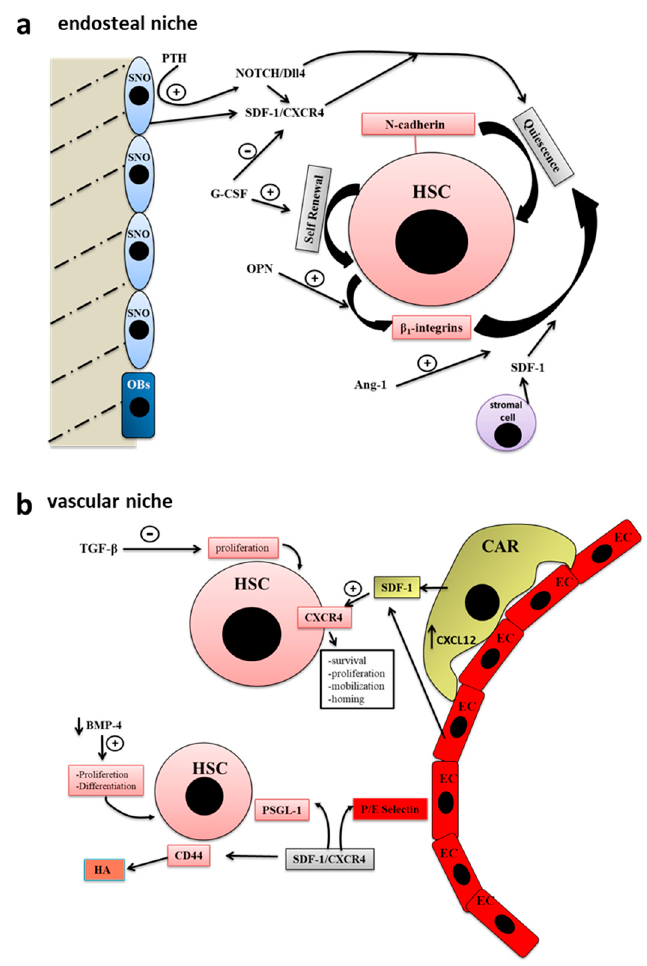
Figure 1. Bone staminal niches (adapted with permission from [29], MDPI, 2017). ( a ) The endosteal niche includes two types of osteoblastic cells, the actively bone-producing osteoblasts (OB) and a type of early osteoblast termed spindle-shaped N-cadherin + CD45- osteoblastic cells (SNO). The intercommunication existing between SNO cells and hematopoietic stem cells (HSCs) regulate the cycle, the fate and activity of both SNO and HSC. In the endosteal niche, stem cells, progenitor cells, stromal cells, growth factors and extracellular matrix (ECM) molecules participate to the regulation of hematopoiesis. ( b ) HSC niche is localized in the center of the bone marrow (BM) cavity close to the sinusoidal endothelium to form the so-called vascular niche. The blood vessels of the BM participate in the regulation of hematopoiesis as well as stem cell mobilization and homing. Endothelial cells are surrounded by adventitial cells, also called CXCL12-abundant reticular (CAR) cells. The closeness between sinusoidal endothelial cells and HSCs is very important for their maturation and for the hematopoietic process.